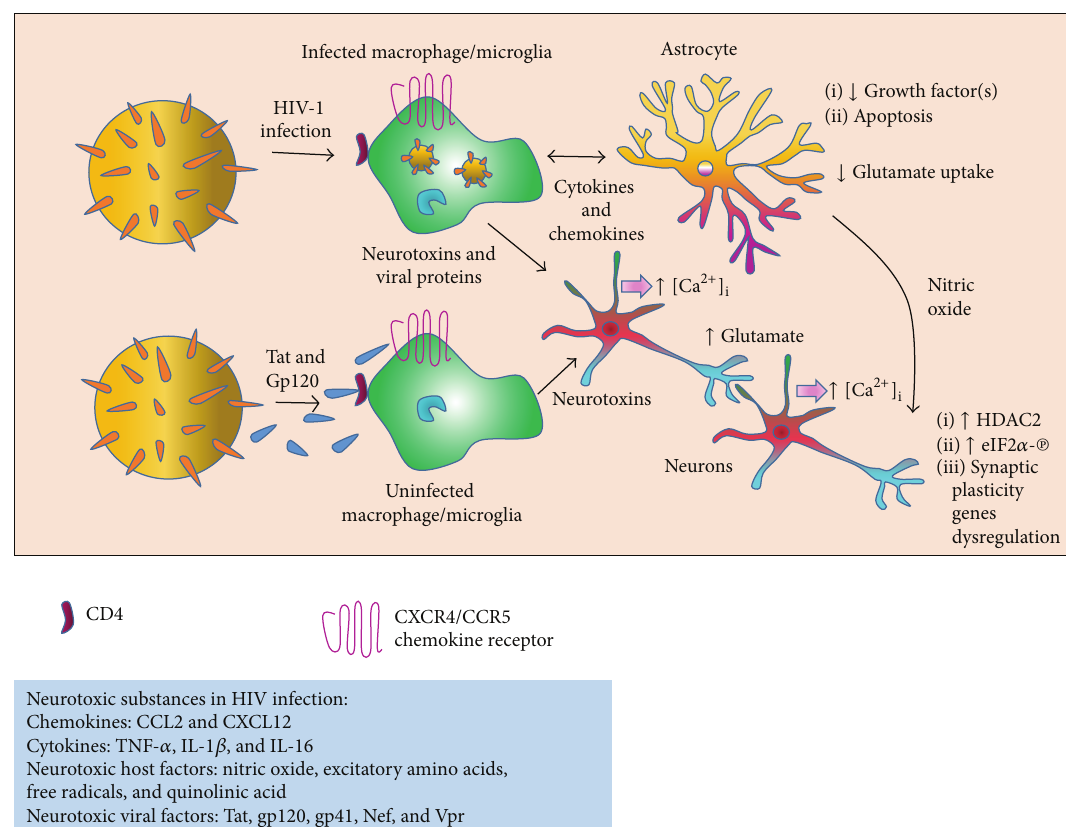
Figure 3: A model of HIV-induced neurotoxicity. Infected microglia or macrophages release viral proteins, chemokines, and cytokines. This activates uninfected microglia and macrophages. Neuronal injury, synapse damage, and cell death occur because immune activated and HIV- infected brain microglia and macrophages release neurotoxic elements. Excessive influx of Ca 2+ ions occurs because of the overactivation of NMDAreceptor-coupledionchannelsthatmediateneuronalinjury.Asaconsequence,potentiallyharmfulenzymes,releaseofglutamate,and free-radical formation are triggered. Subsequently, glutamate overstimulates NMDA receptors on nearby neurons, which causes additional injury.UpregulationofHDAC2expressionandincreasedeIF2 𝛼 -phosphorylationleadstothedysregulatedsynapticplasticitygeneandprotein expression which results in impaired synaptic